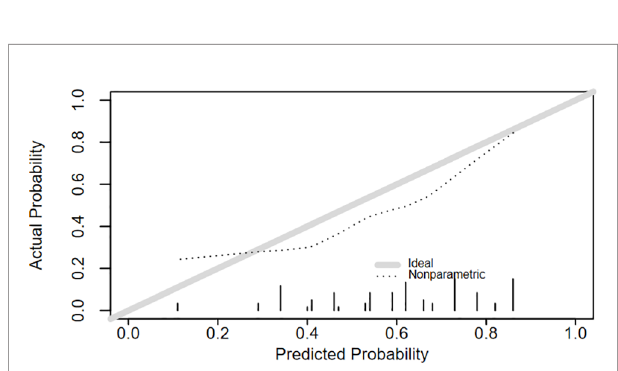
FIGURE 3 | The calibration curve of the nomogram for predicting LNM in